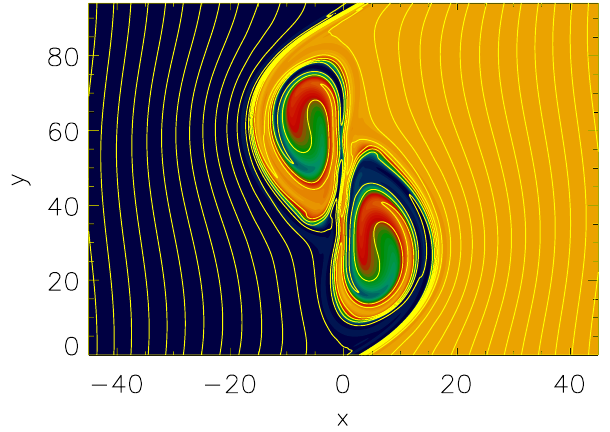
Fig. 8. Shaded isocontours of the passive tracers at t = 275, V 0 = 2. From the left to the right side along the x-axis, the passive tracers, purely advected by the velocity field, represent the magnetospheric (blue) and magnetosheath (yellow) plasma separated by the transi- tion region (green and orange). Yellow curves represent magnetic field lines in the (x,y)-plane.